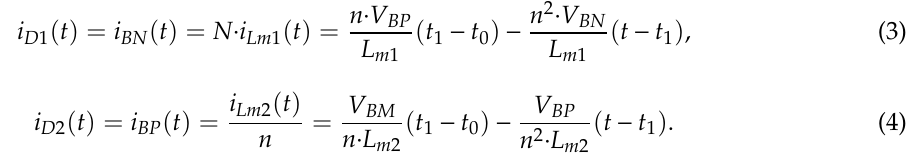
Figure 6. Balancing algorithm for the proposed balancing circuit.